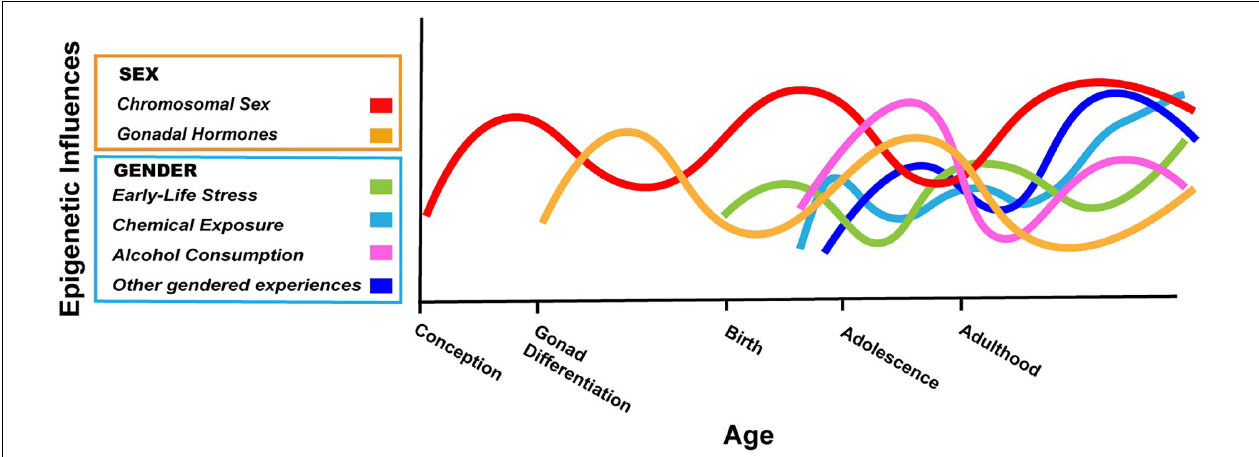
FIGURE 1 | Hypothetical depiction of the complex interplay of sex and gender on the brain epigenome throughout the lifespan. Chromosomal sex is determined at conception and can have effects on the epigenome throughout life (red). The gonads differentiate after the first 10 weeks of fetal life in humans; thereafter, sex differences in gonadal hormones can have acute or lasting effects on the epigenome (gold). The gendered experiences described in this review start as early as birth (early life stress based on gender; green) and continue into adolescence and adulthood (cosmetic use, alcohol consumption; light blue, purple). Many other gendered experiences not explicitly addressed in this review will also impact the neuroepigenome (dark blue). The relative contribution of various factors and how they may change throughout development are not known, but the effects of biological sex and gender will interact in myriad ways throughout life. In some cases, gender may amplify epigenetic differences due to sex, whereas in other cases, gendered experiences may counteract differences in the epigenome based on biological sex. Not shown here is the fact that with our current ability to know the sex of an unborn child, gender can start before birth (Al-Akour, 2008).